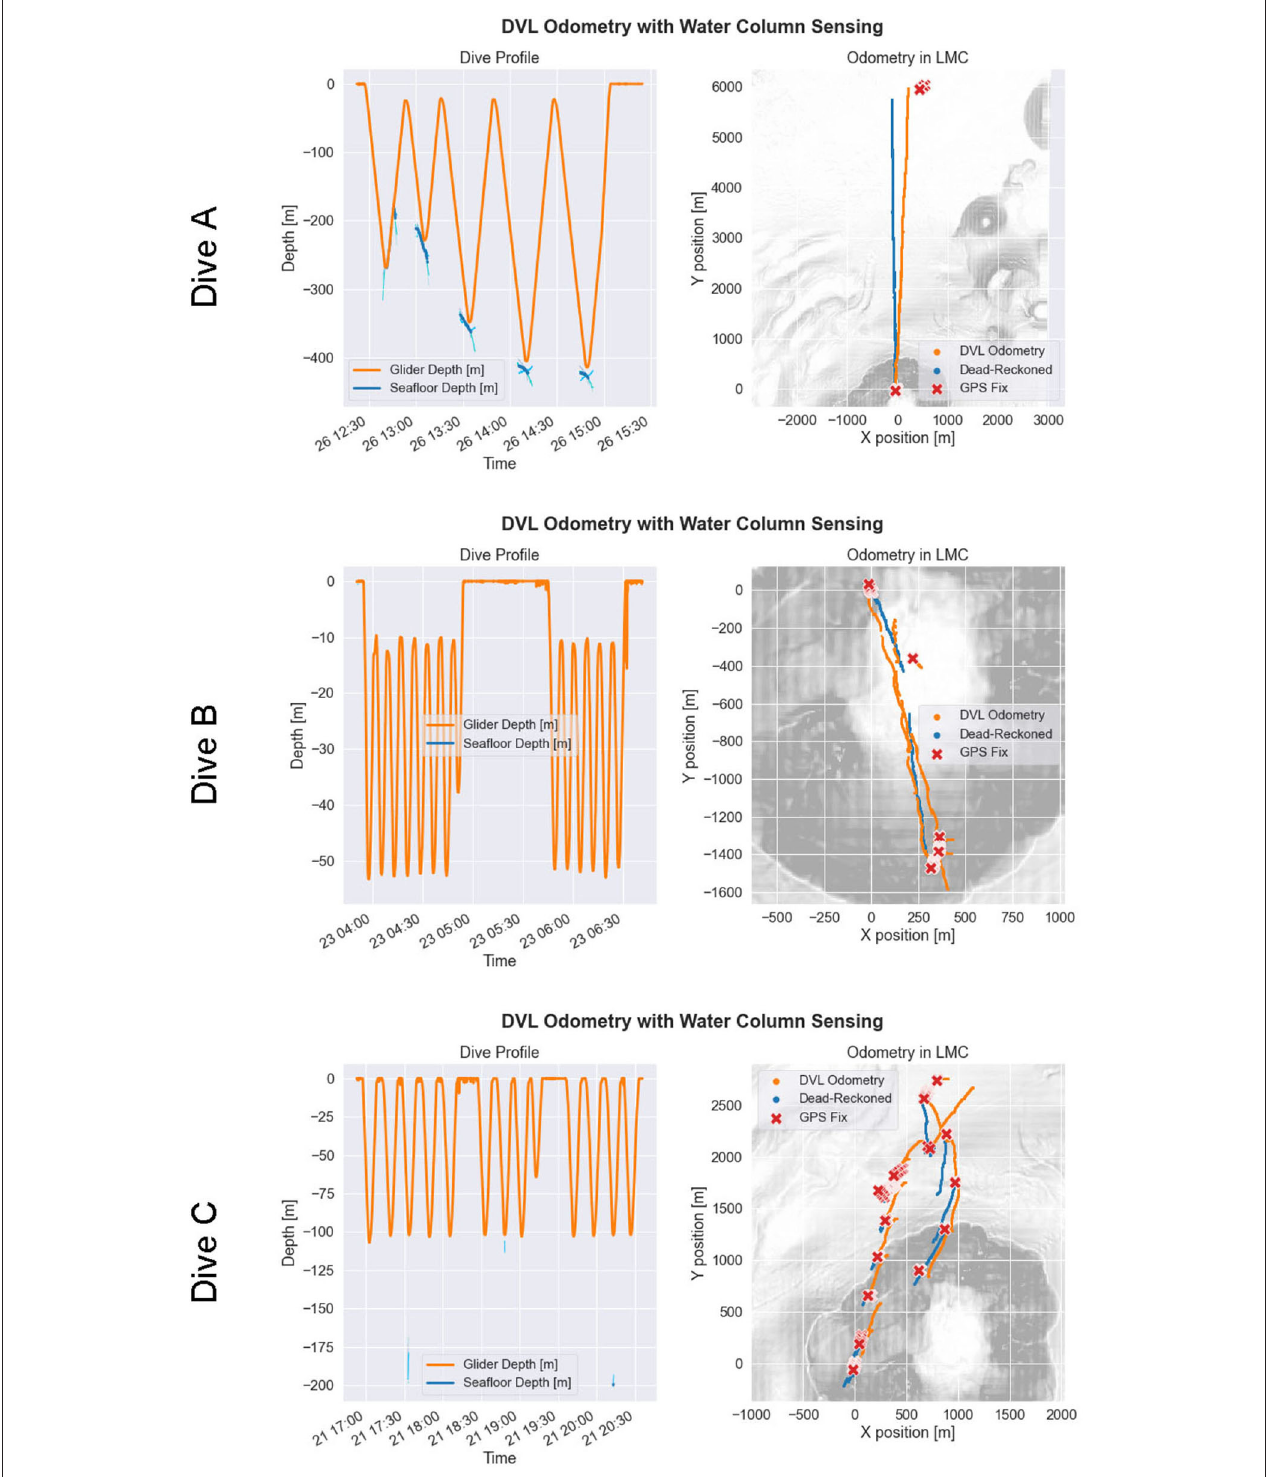
FIGURE 9 | Post-process navigation reconstruction for a selection of glider missions where Doppler velocity log (DVL) bottom track was sparse or absent. Each row of the figure corresponds to a particular glider mission. The first column shows the glider depth (orange) and estimated seafloor depths (shades of blue) over time using each of the four DVL beams. The second column shows the dead-reckoned odometry from the glider flight computer (blue), the improved DVL-reinforced odometry (orange), and the GPS position updates (red), where the glider starts each mission at the origin of the local mean coordinates (LMC) coordinate system. The gray-scale underlay shows